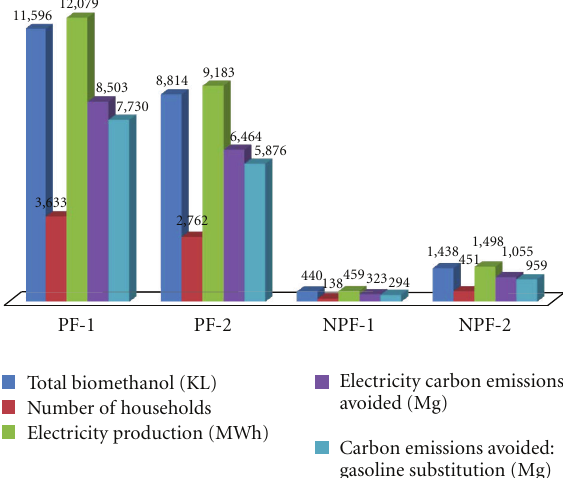
Figure 5: The amount of biomethanol produced and the amount of fossil-resource-derived electricity and gasoline, this amount can potentially replace and avoid carbon emissions when converting 5% of the annually available biomass collected from certified production forests (NPF and